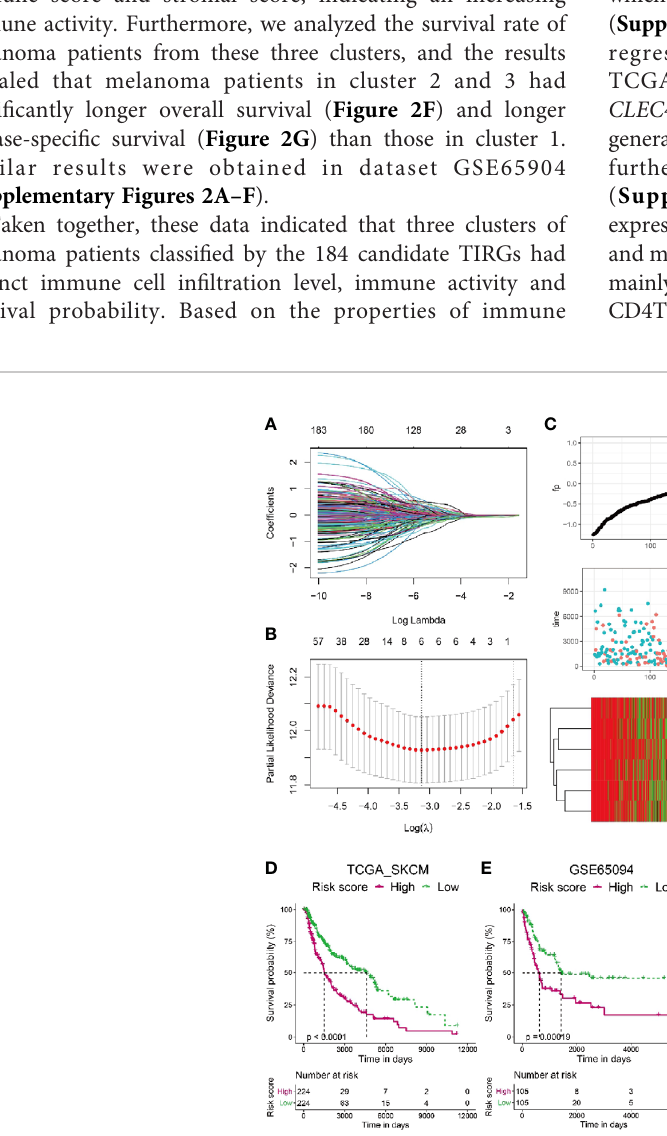
FIGURE 3 | Construction of a risk score based on six signature genes. (A, B) The LASSO Cox regression model was constructed from 184 signature genes, and the tuning parameter ( l ) was calculated based on the partial likelihood deviance with ten-fold cross validation. The six signature genes were identi fi ed according to the best fi t pro fi le. (C) Melanoma patients in the TCGA training set were divided into two populations according to the median value of the risk scores. (D – F) Melanoma patients with lower risk score have signi fi cantly longer survival in the TCGA whole set (D) , GSE65094 data sets (E) and GSE22153 data sets (F)